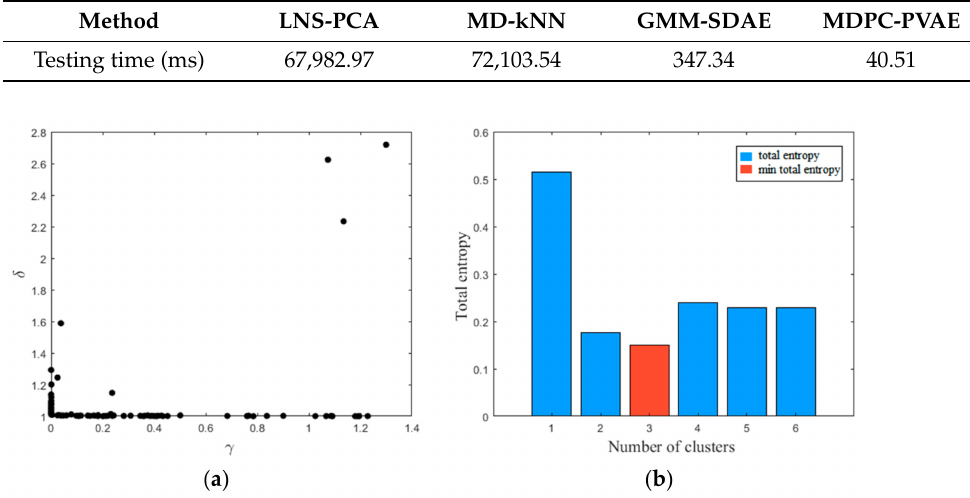
Table 3. Testing time of 2000 sample for the four methods.